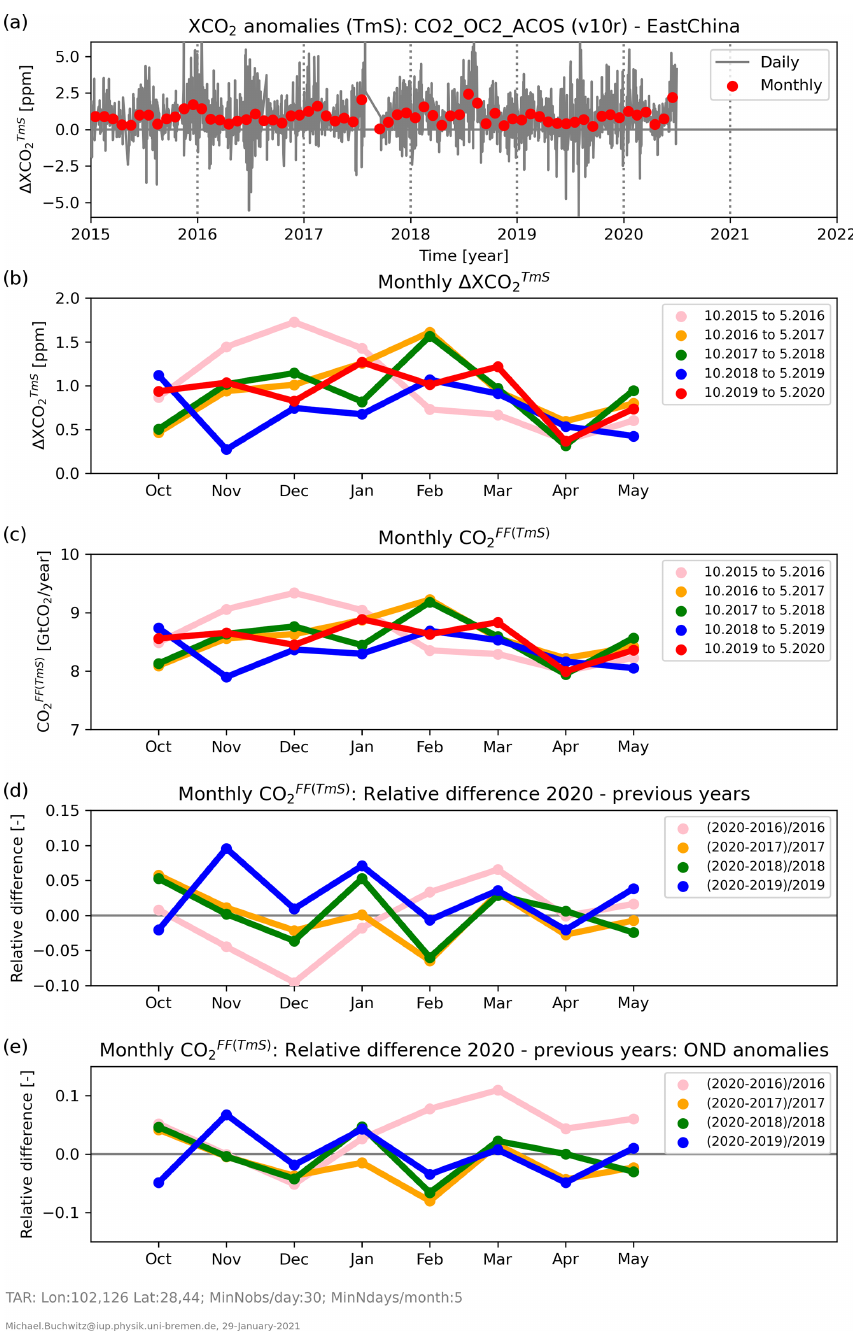
Figure A2. The same as Fig. 7 but using the TmS